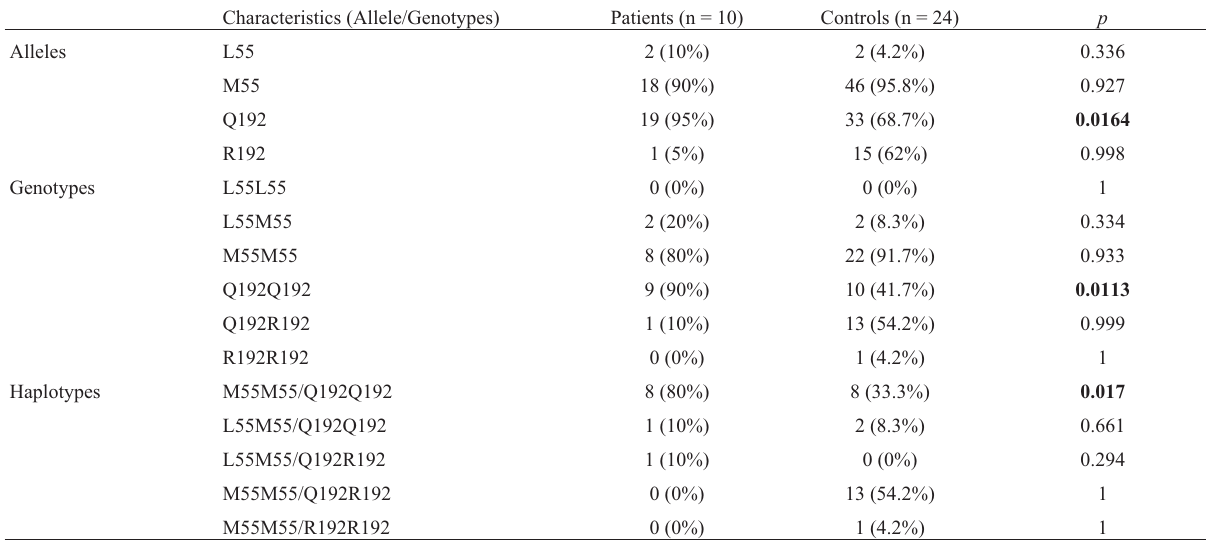
Table 2 - Paraoxonase-1 allele, genotype, and haplotype distributions of L55M and Q192R polymorphisms in patients and healthy individuals of the hy- percholesterolemia family. Characteristics